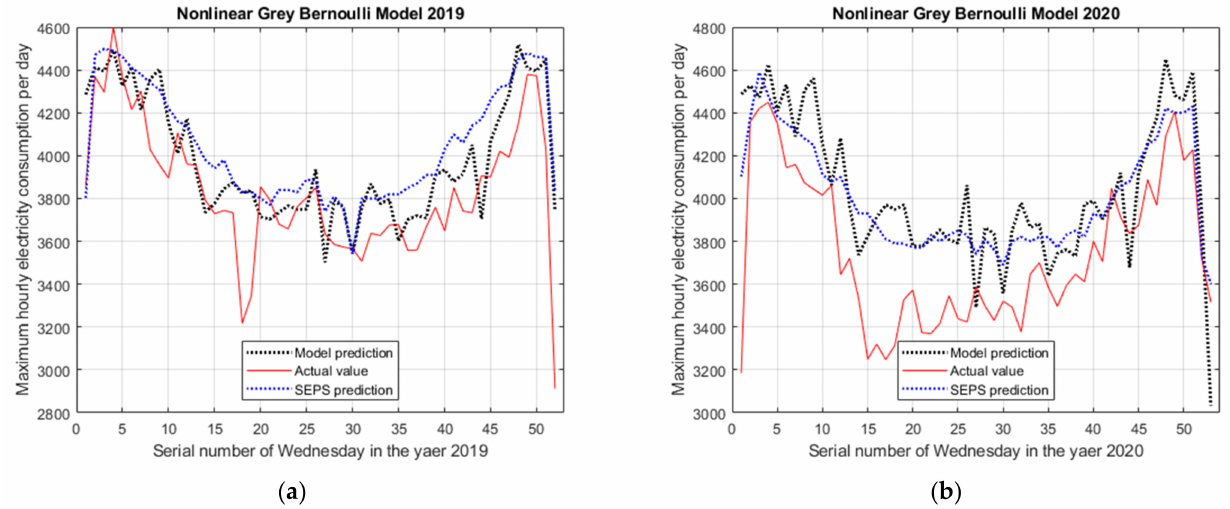
Figure 7. Prediction of Nonlinear Grey Bernoulli Model set. ( a ) Prediction of NGBM(1,1) set for 2019, ( b ) Prediction of NGBM (1,1) set for